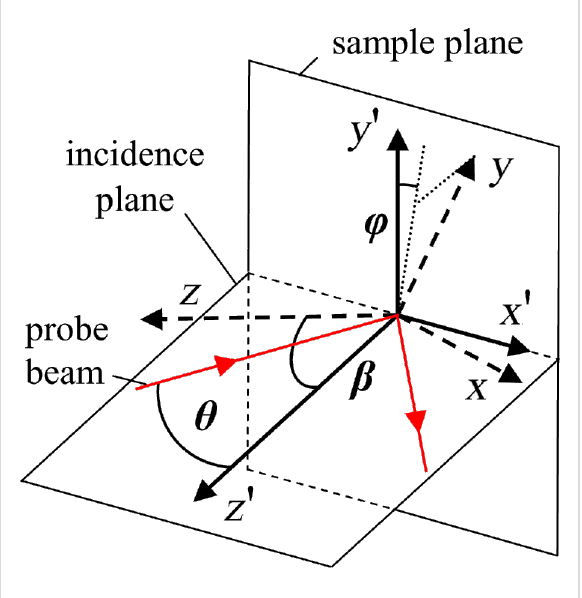
with r pp , r ss , r ps , r sp ( t pp , t ss , t ps , t sp ) representing the reflection (transmission) coefficients for p - , s-, and cross-polarizations, re-